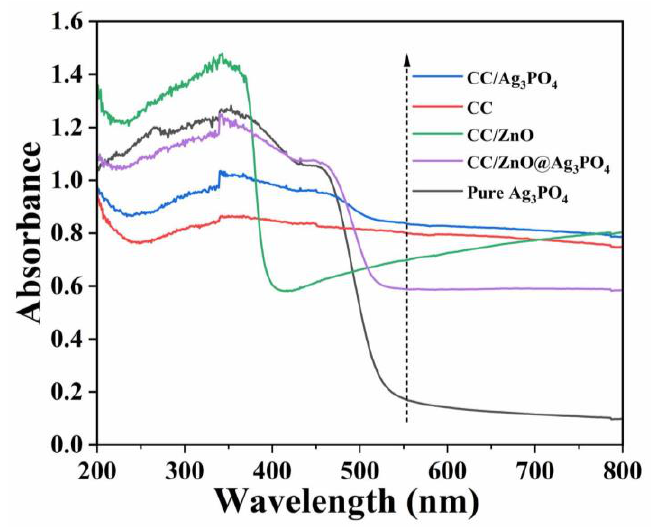
Figure 6. UV – Vis diffuse reflectance spectra of the as-prepared samples.